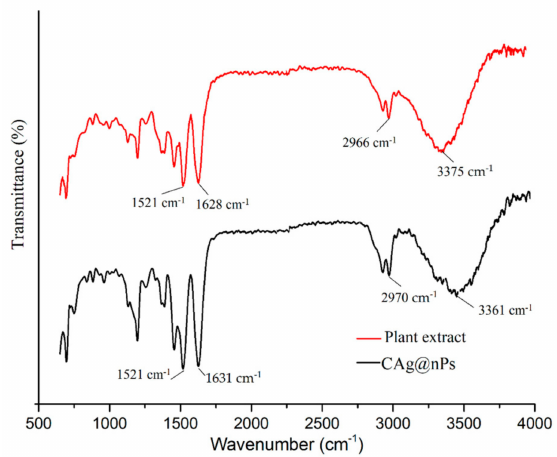
Figure 2. FTIR spectra of plant extract and biosynthesized